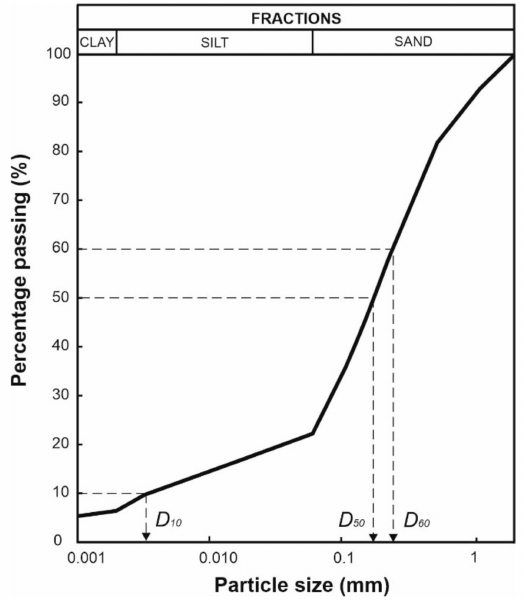
Figure 4. Particle size distribution of soil used in the experiment. Table 2. Soil